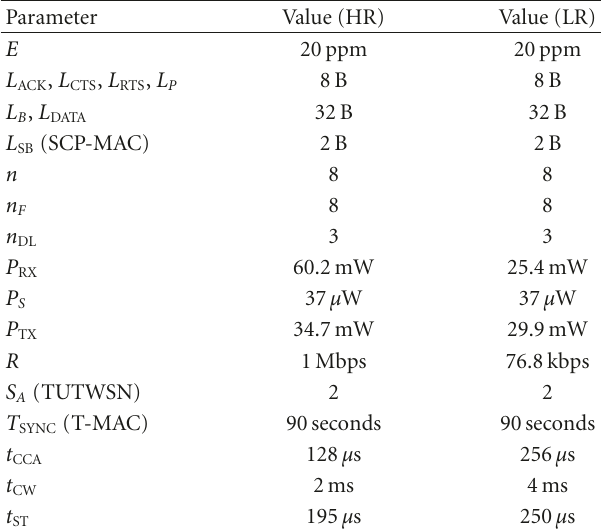
Table 2: Utilized parameter